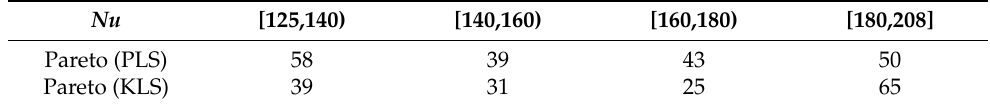
Table 6. The distribution for Pareto solutions of Nu for Op-II.